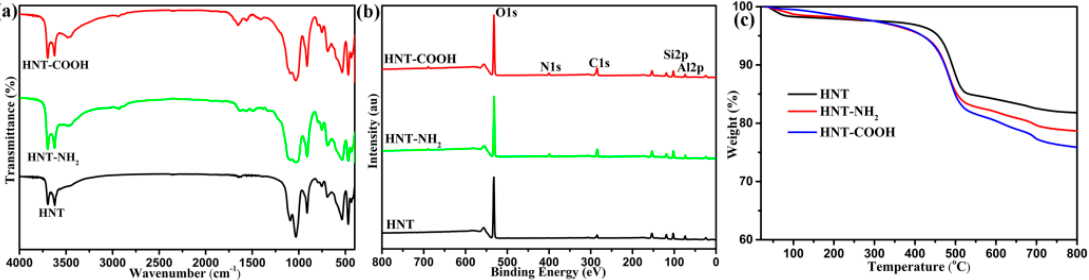
Figure 2. ( a ) FTIR spectra; ( b ) XPS spectra; and ( c ) TGA curves of untreated and modified HNTs.